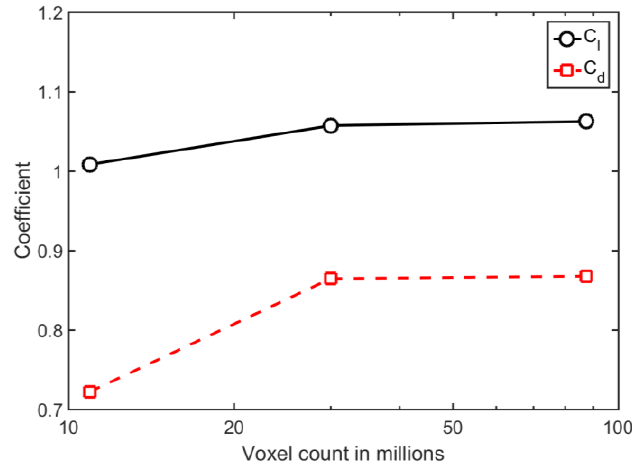
Figure 5. The variation of the lift coefficients ( C l ) and drag coefficients ( C d ) produced by the baseline flap side-edge against the grid resolution level.